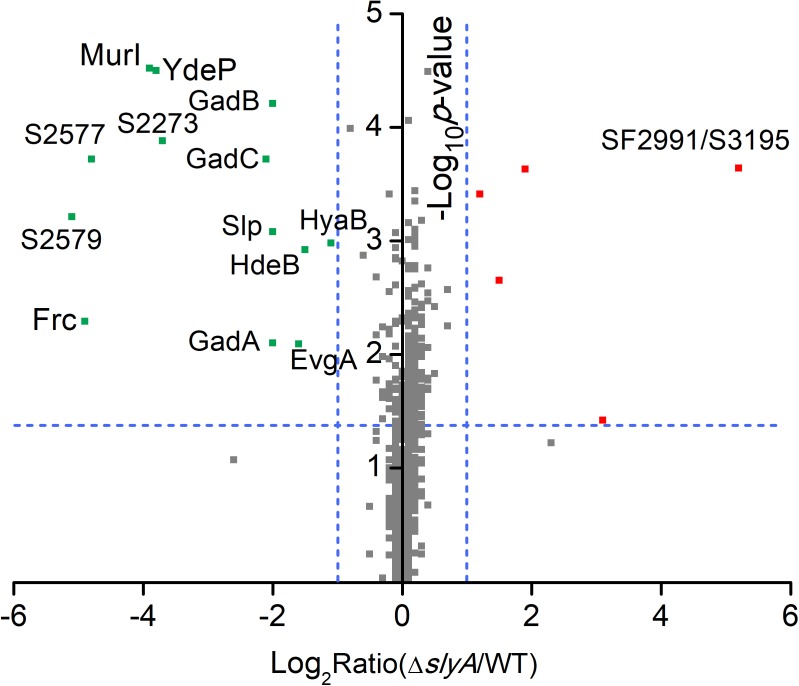
Quantitative proteomic data of Shigella WT and ΔslyA strains. A protein volcano plot was shown with the logarithmic values of the abundance ratios reported on the x-axis. The y-axis plots negative logarithmic p-values determined from the t-test on data from three biological replicates. Dotted lines denote two-fold (vertical) and p < 0.05 cutoff (horizontal). Proteins with homologous sequences may not be distinguished in LC-MS/MS experiments unless unique peptides were detected. As a result, the detection of SF2991 and S3195 is considered as a single protein identification (denoted as SF2991/S3195).